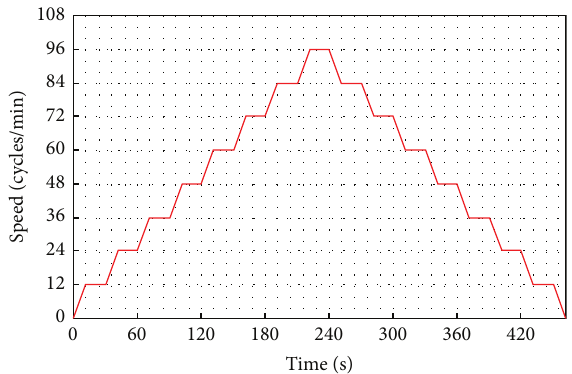
Figure 4: Imposed speed profile of the tribometer as proposed by Ngo [18].